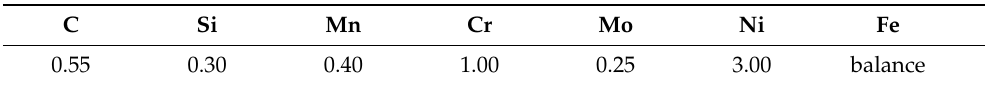
Table 1. Composition (average %) of K605 Böhler